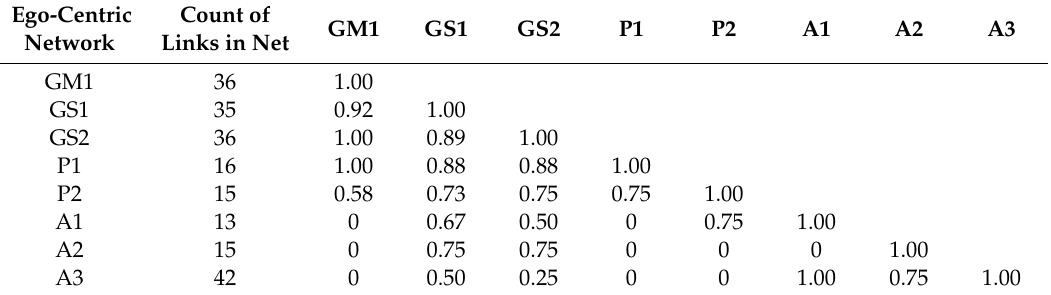
Table 2. Proportion of same ties among overlapping actors.